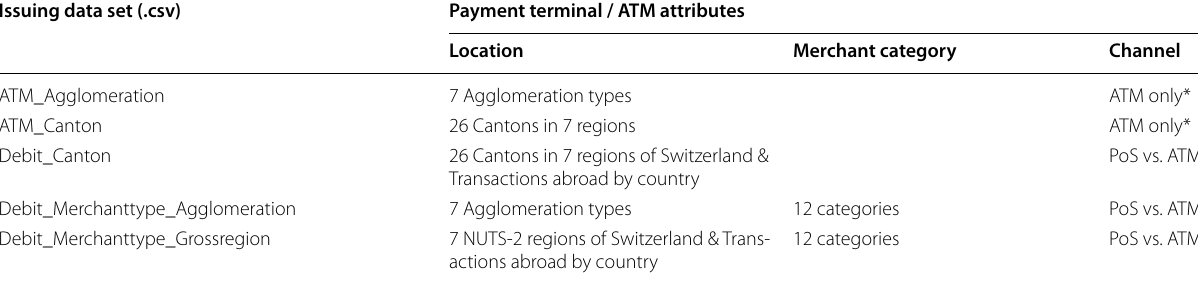
Data marked with * are available from 2020.1.1 only. These data sets are based on a constant sample of ATM’s in Switzerland, which had been migrated to the “ATMfutura” software as per 2020.1.1. Data set includes withdrawals from and deposits at ATM. See Sect. 5 for more details